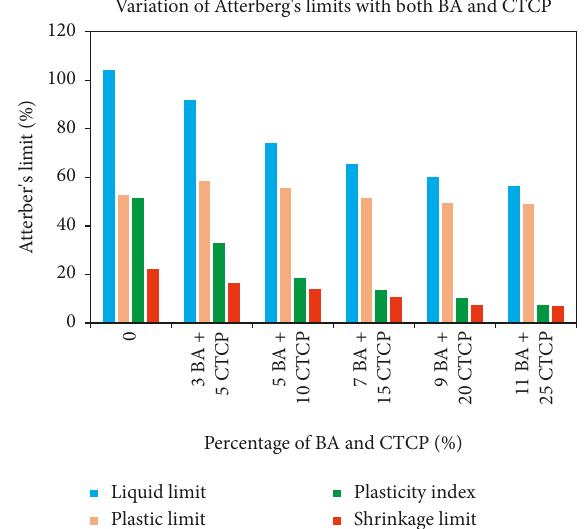
Figure 6: Combined effect of BA and CTCP on Atterberg’s limit.